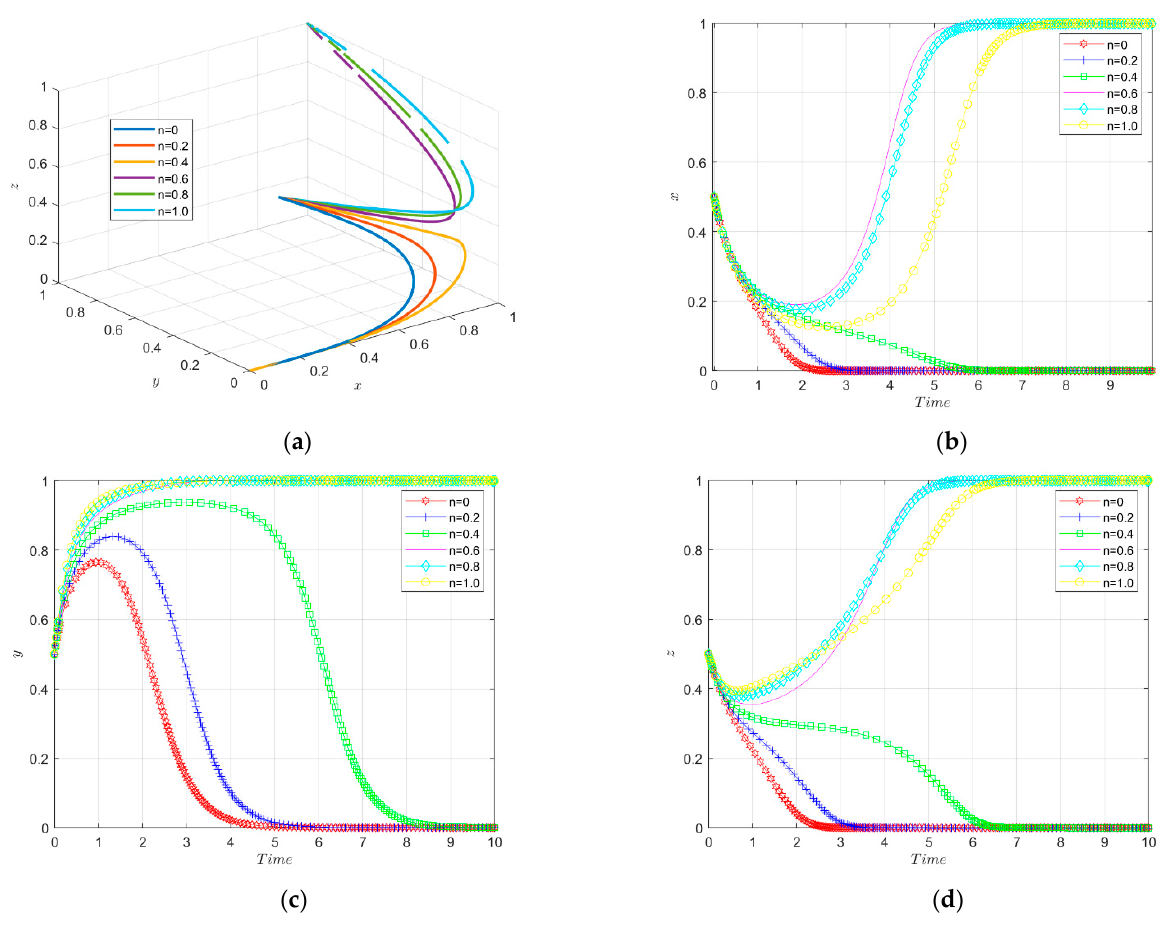
Figure 13. ( a ) Evolutionary trajectory of the tripartite game under n changes. Evolutionary trajectories of enterprises ( b ), government ( c ) and financial institutions ( d ) under different carbon taxes.